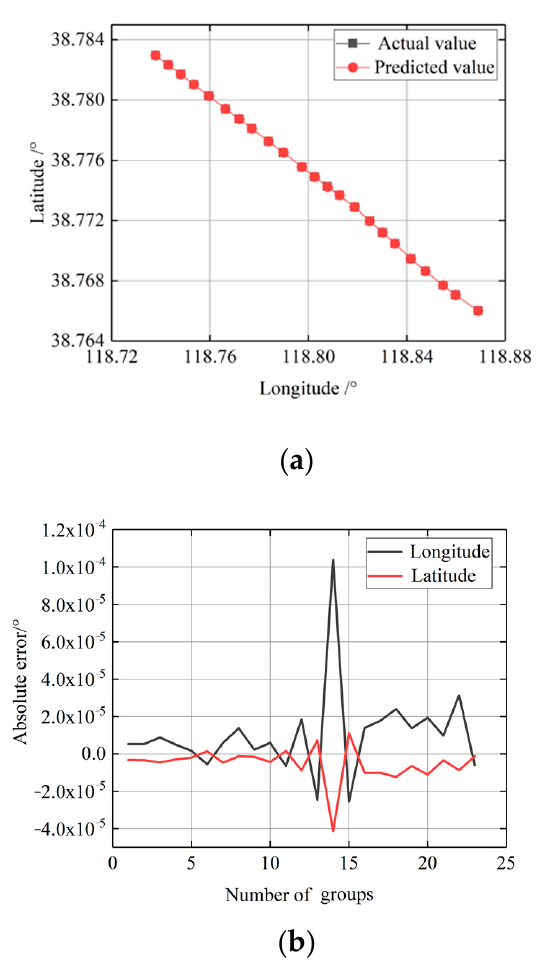
Figure 9. Prediction results of b-trajectory using the ACDE-SVR model. ( a ) Comparison of predicted and actual values of b-trajectory; ( b ) Longitude and latitude absolute error values of b-trajectory.